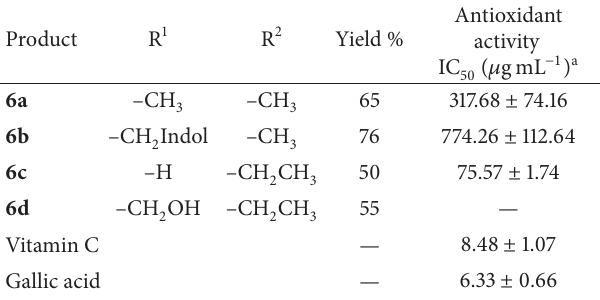
Table 3: Yield and antioxidant activity of bis-(1,2,3-triazolylmeth- yl)amino esters 6